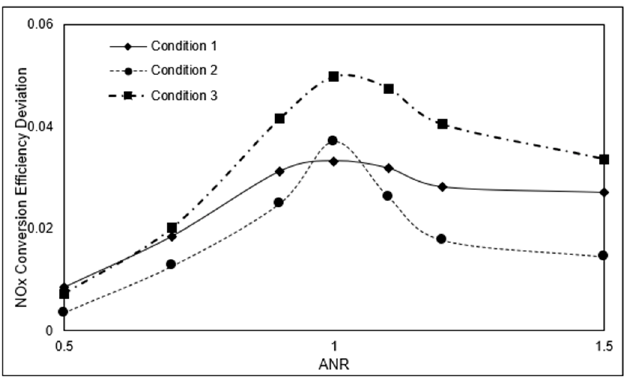
Figure 13. NOx emission results and NH 3 slip results during NRTC with different SCR substrate concepts.